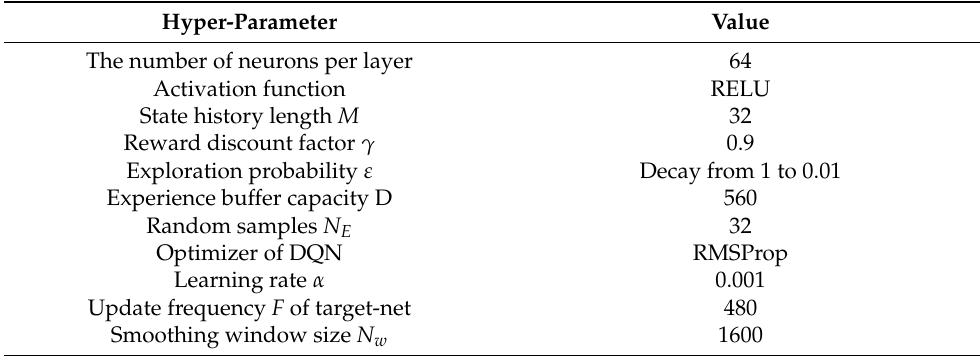
Table 2. OA-DLMA